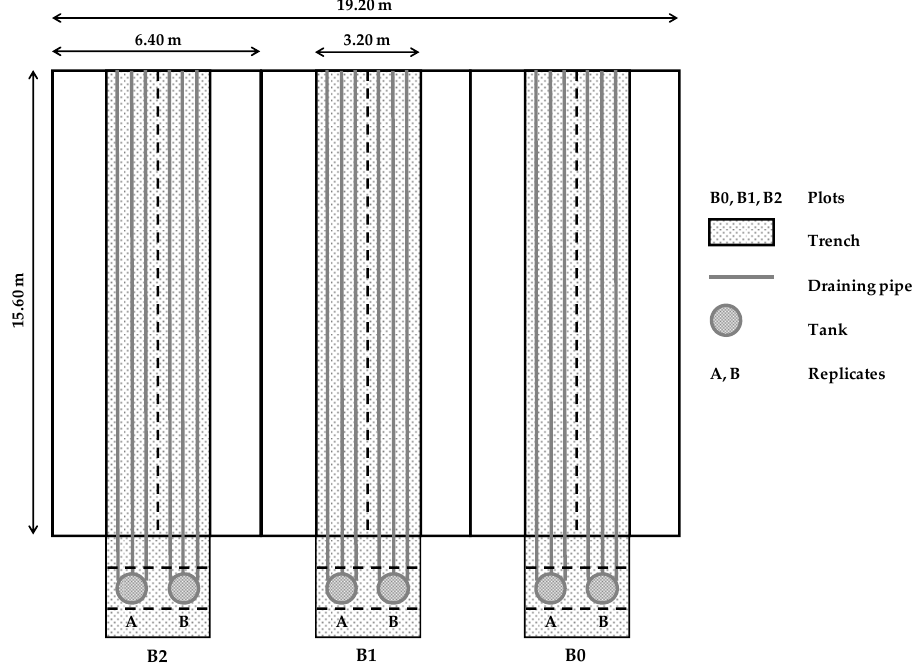
Figure 2. Layout of the experimental field.